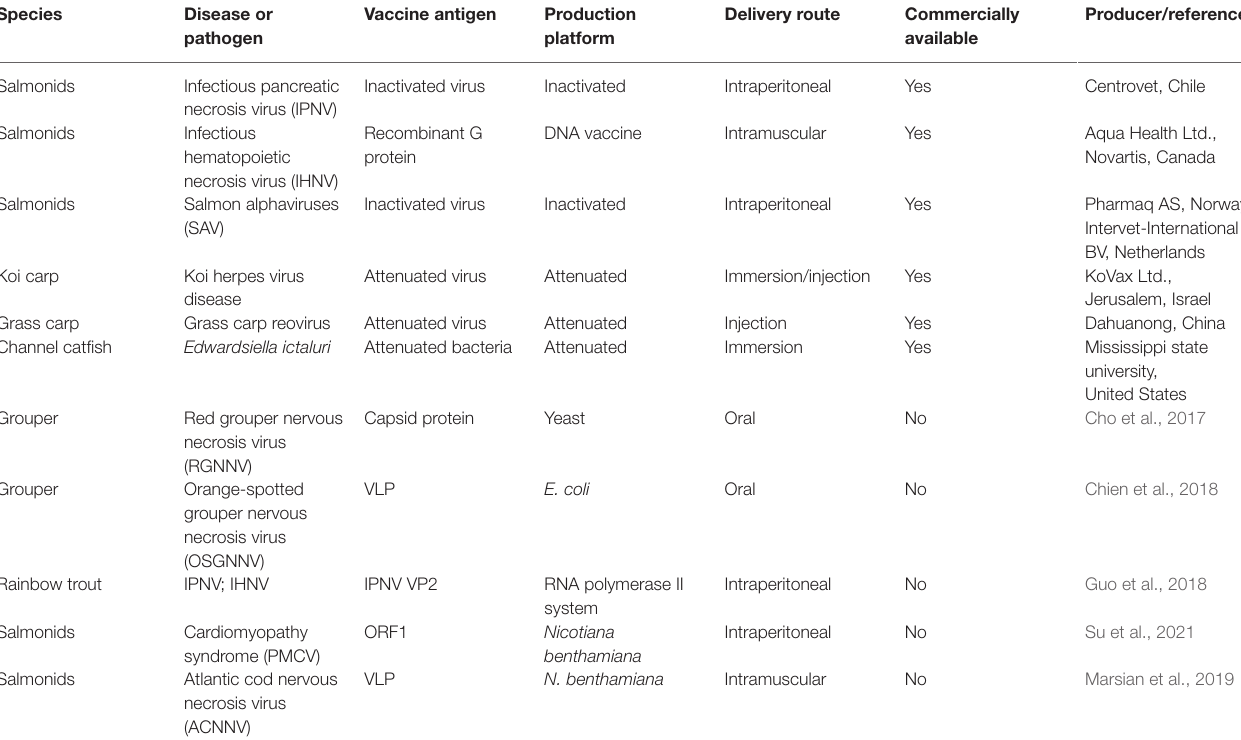
TABLE 2 | Representative commercial fish vaccines and plant-produced fish vaccines under development.